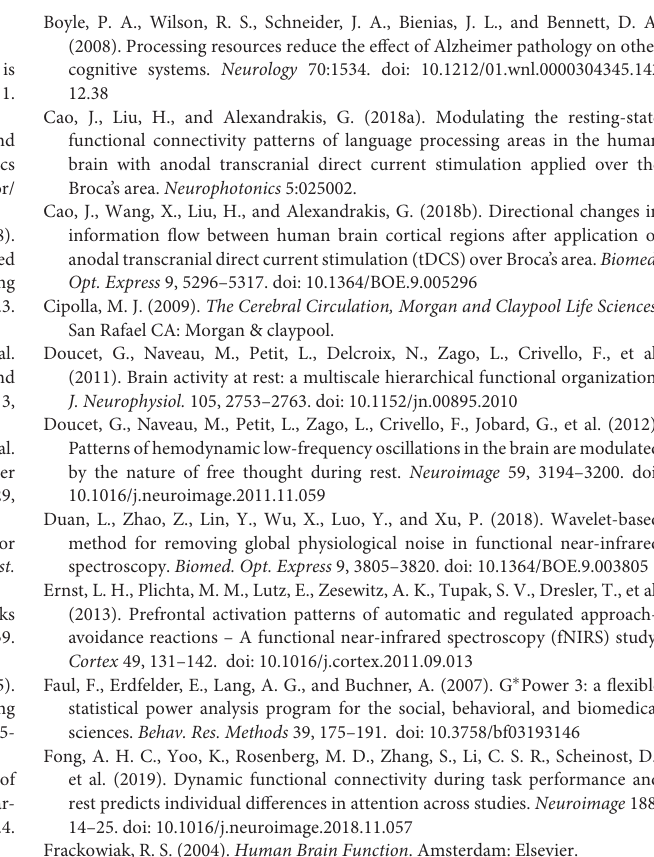
FIGURE S3 | Significant dPTE and DC in the myogenic frequency band for inactive and active subjects during the handgrip task for (cid:49) Hb. Directed PTE t -values for each ROI as a color-coded map for inactive subjects (A–C) and active subjects (D–F) . Hot (yellow-reds) and cold (light blue-dark blue) colors indicate information outflow and inflow, respectively. Arrows indicate statistically significant information flow between functional regions for inactive (G–I) and active subjects (J–L) . Black arrows ( p < 0.05); Red arrows ( p < 0.01). Eleven regions of interest (ROIs) were mapped: left and right frontopolar (lFP; rFP) (red), left and right TABLE S1 | Spatial registration of fNIRS channel positions on a standard brain fMRI atlas. MNI coordinates displayed as mean (SD); r-right contralateral brain hemisphere; l- left ipsilateral brain hemispheres. TABLE S2 | Preprocessing input parameters used in